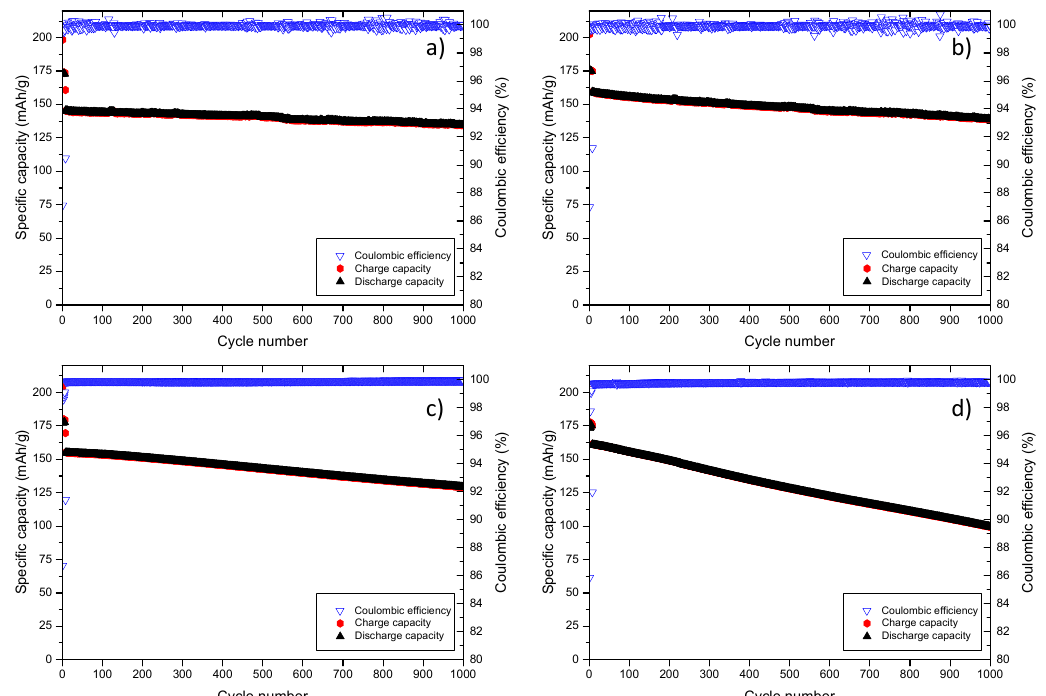
Figure 7. Long-term cycling profiles of the NMC / T44graphite cells containing electrolyte formulations: ( a ) 1M LiPF 6 in EC:DMC (1:1) without cyclic voltammetry (CV) step (cell a), ( b ) 1M LiPF 6 in EC:DMC (1:1) including CV step (cell b), ( c ) 1M LiPF 6 in BN:EC (9:1) + 3% FEC without CV step (cell c), ( d ) 1M LiPF 6 in BN:EC (9:1) + 3% FEC including CV step (cell d) in the voltage range of 3.00–4.30 V.